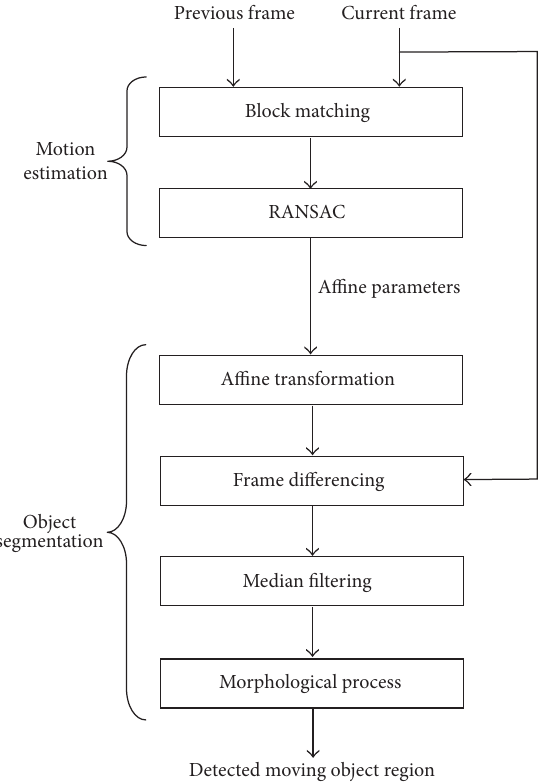
Figure 1: Overall algorithm of moving target detection using image registration